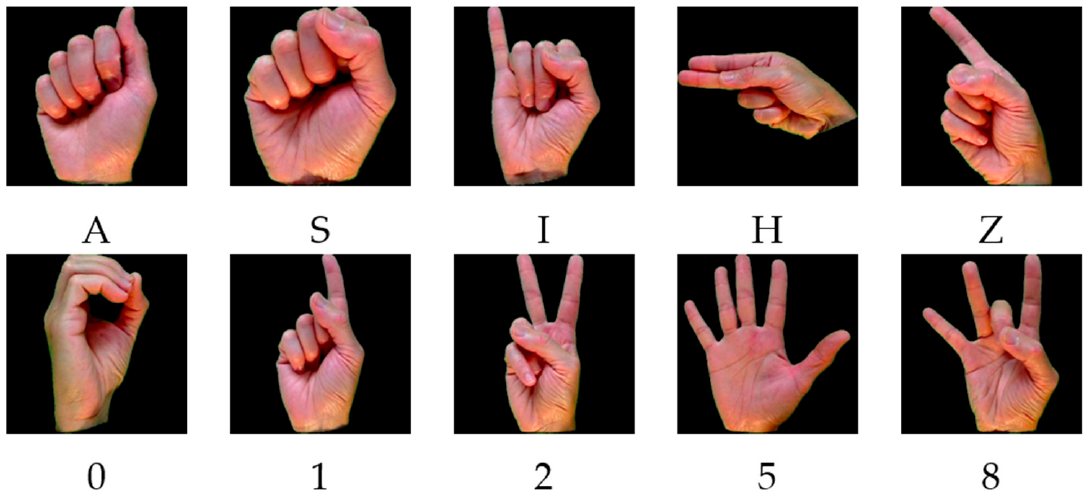
Figure 8. A subset of alphabets and numbers from the Kaggle dataset.